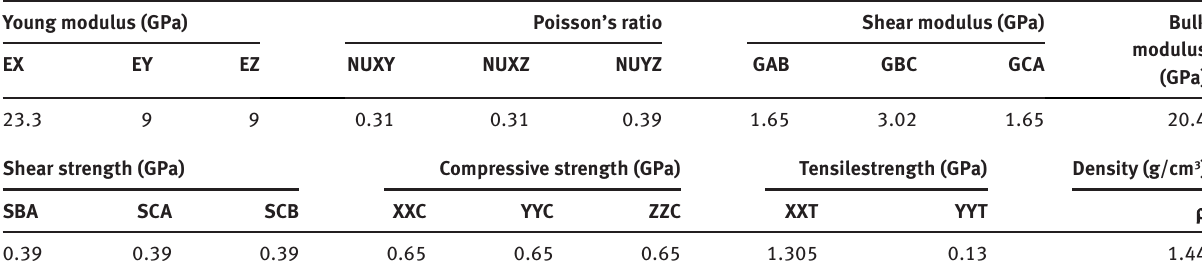
Table 2: Material parameters of composite. Young modulus (GPa)